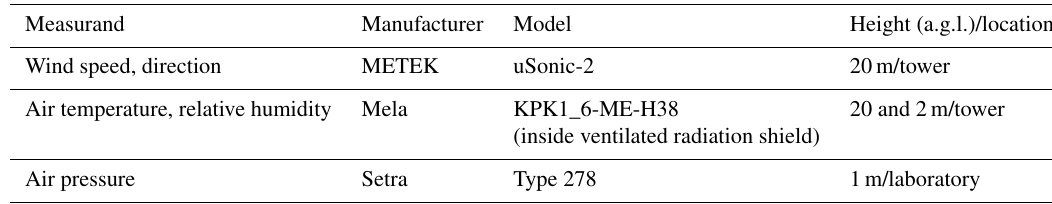
Table A2. Meteorological measurements by MPI-BGC at